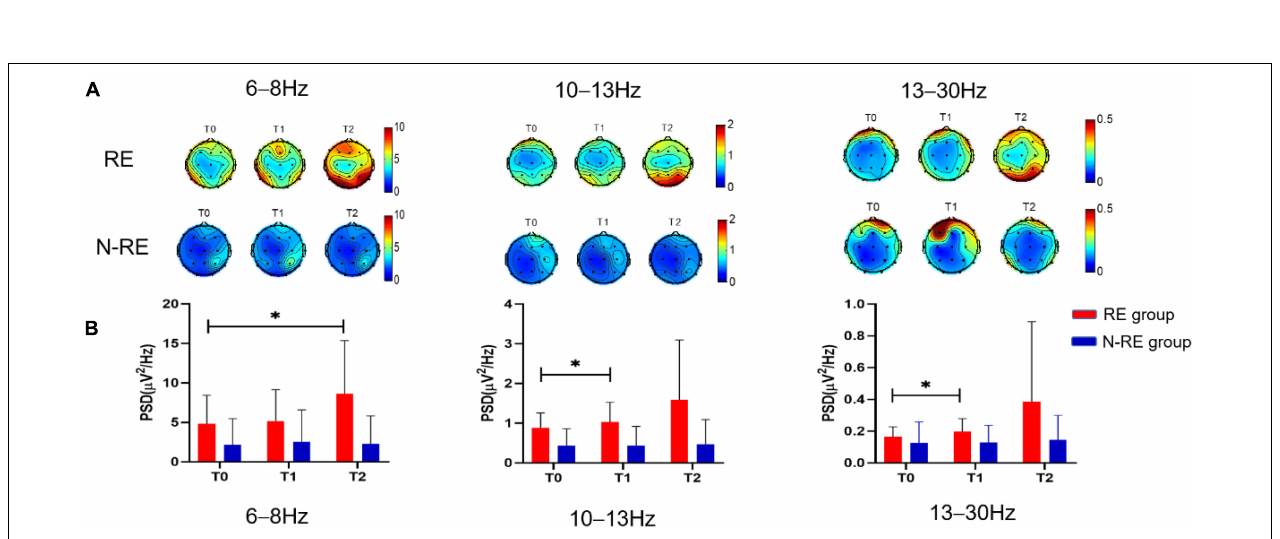
FIGURE 4 | The PSD topographic map of the RE group and the N-RE group (A) , and the PSD of the RE group and the N-RE group of the parieto-occipital region (B) before the experiment (TO), after a single session of Tdcs (TI) and after the treatment of 5 days (T2). PSD power spectrum density, RE responsive group, N-RE non-responsive group. ∗ p <